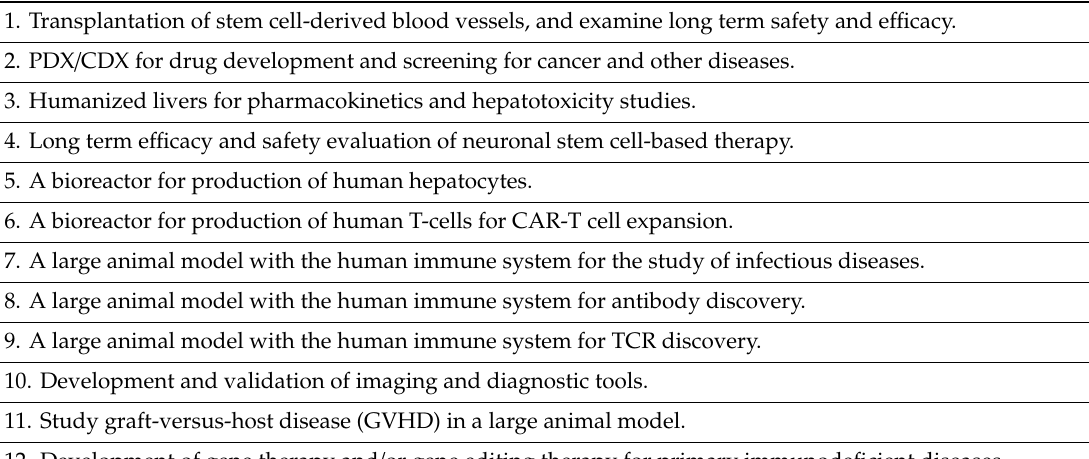
Table 3. Example applications of immunodeficient